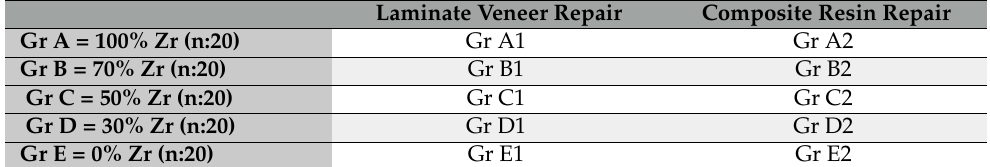
Table 2. Specimen Groups.